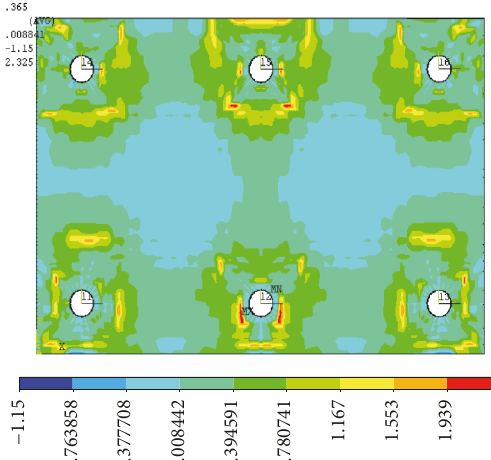
Figure 4: Principal tensile stress when the displacement resulting from the corrosion-induced expansion reaches 0.00365 mm.